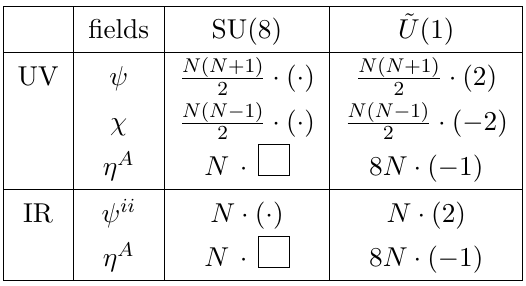
Table 1 . Full dynamical Abelianization in the ψχη